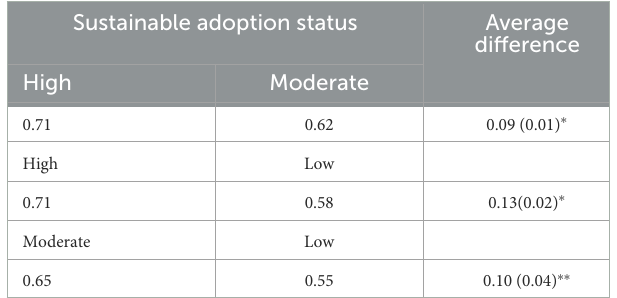
TABLE 3 Sustainable adaptation to climate change impact on food security.